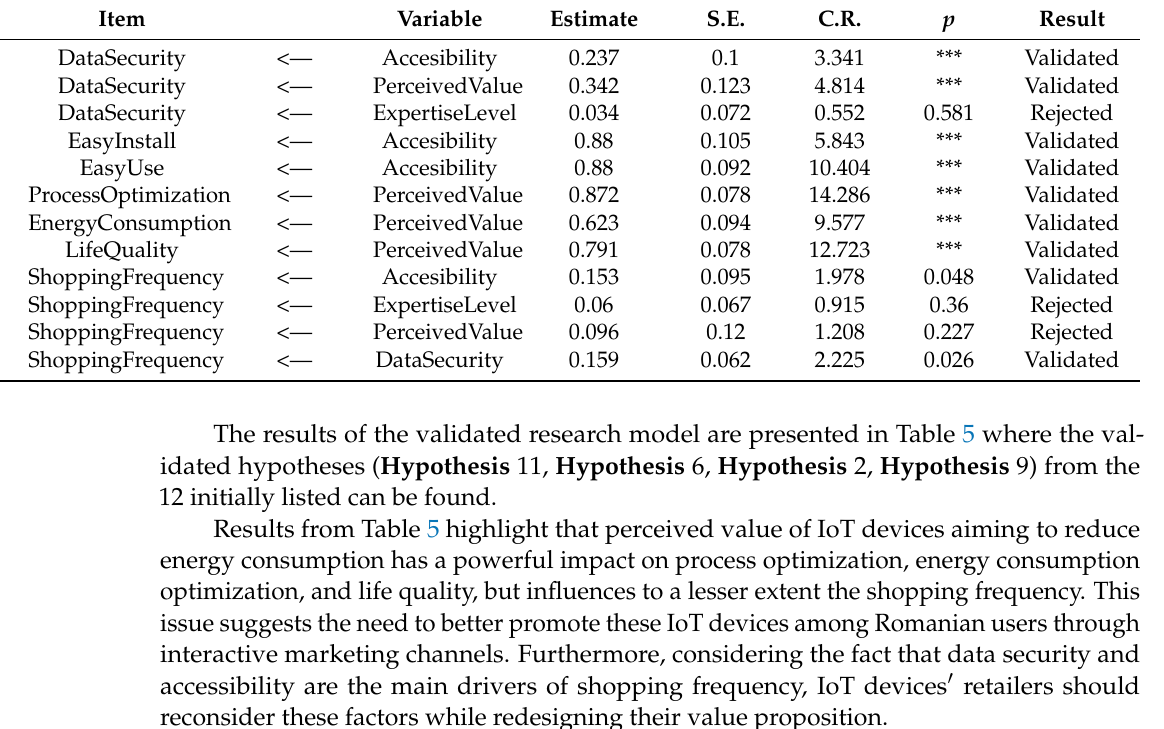
Table 5. The results of the proposed research framework (*** p < 0.001; !—for the hypotheses identified in the conceptual framework).